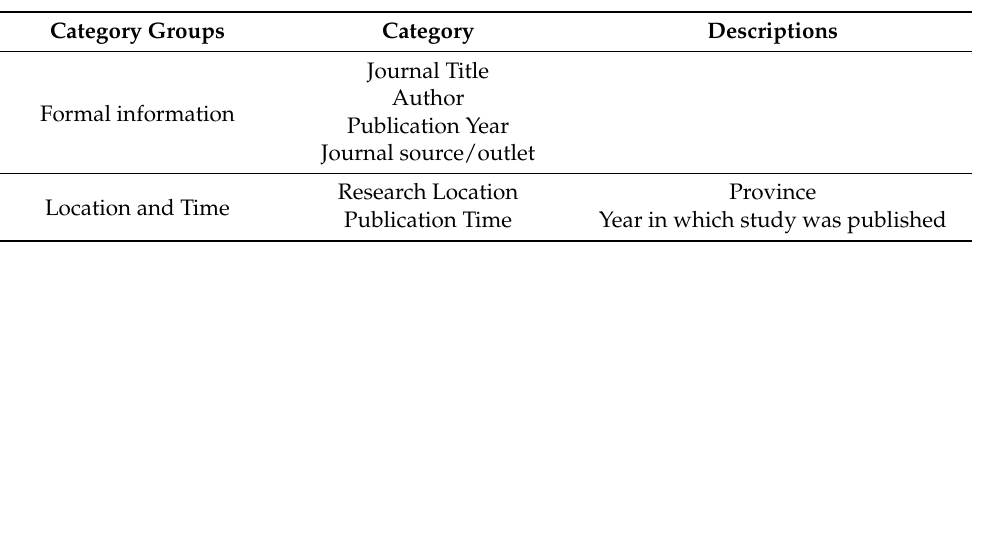
Table A1. Contextual aspects of the journal and characteristics of the study